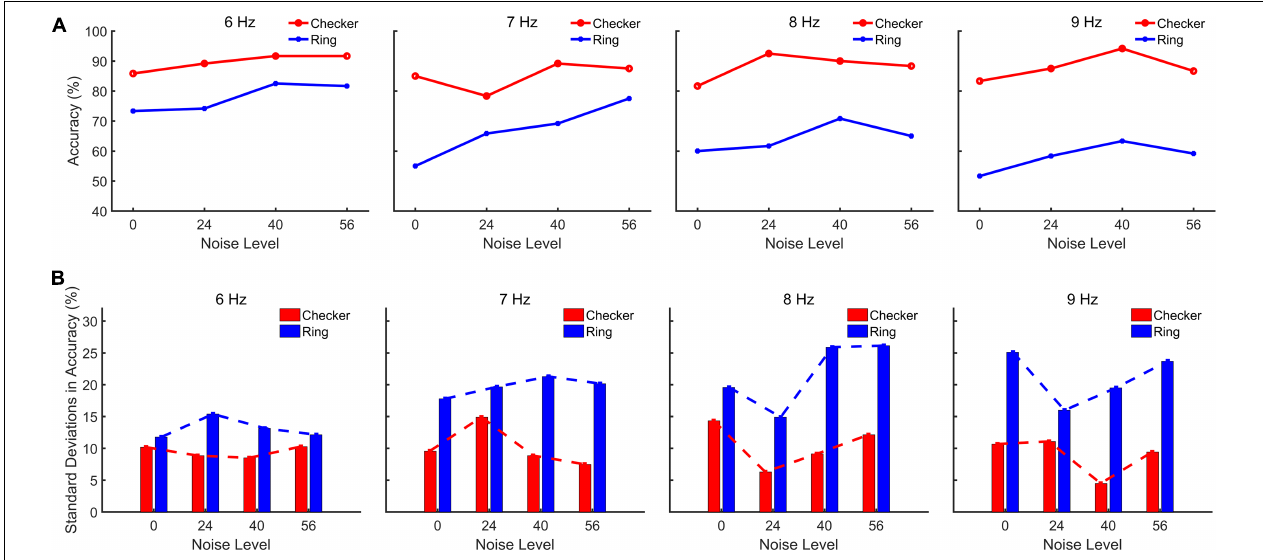
FIGURE 5 | Grand-averaged detection accuracies as a function of NSD values. (A) Averaged detection accuracies with a time-window length of 2 s for all subjects. (B) Standard deviations of the averaged detection accuracies across